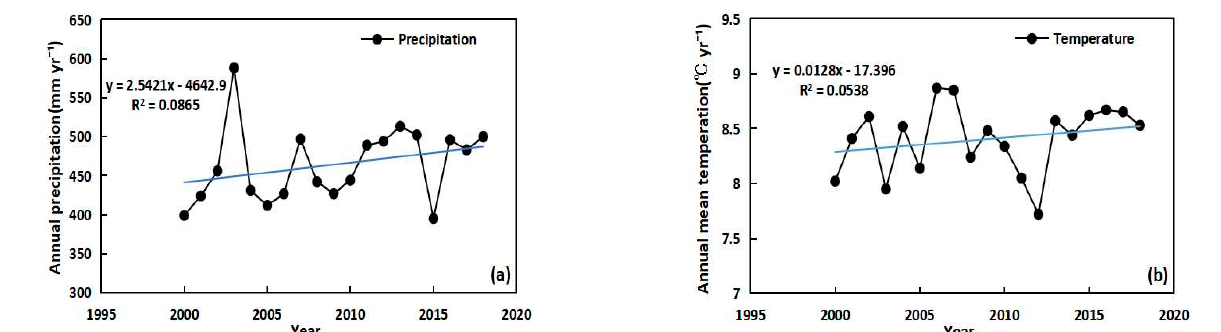
Figure 4. Annual precipitation ( a ) and annual mean temperature ( b ) of LP from 2000 to 2018.